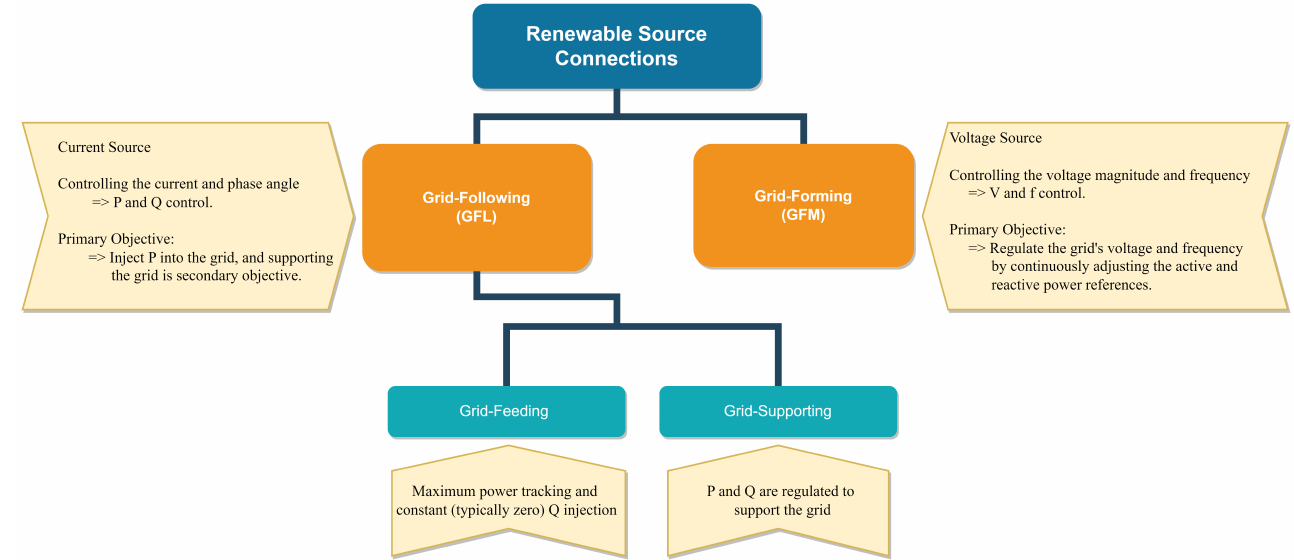
Figure 1. Distinguishing characteristics of GFL and GFM